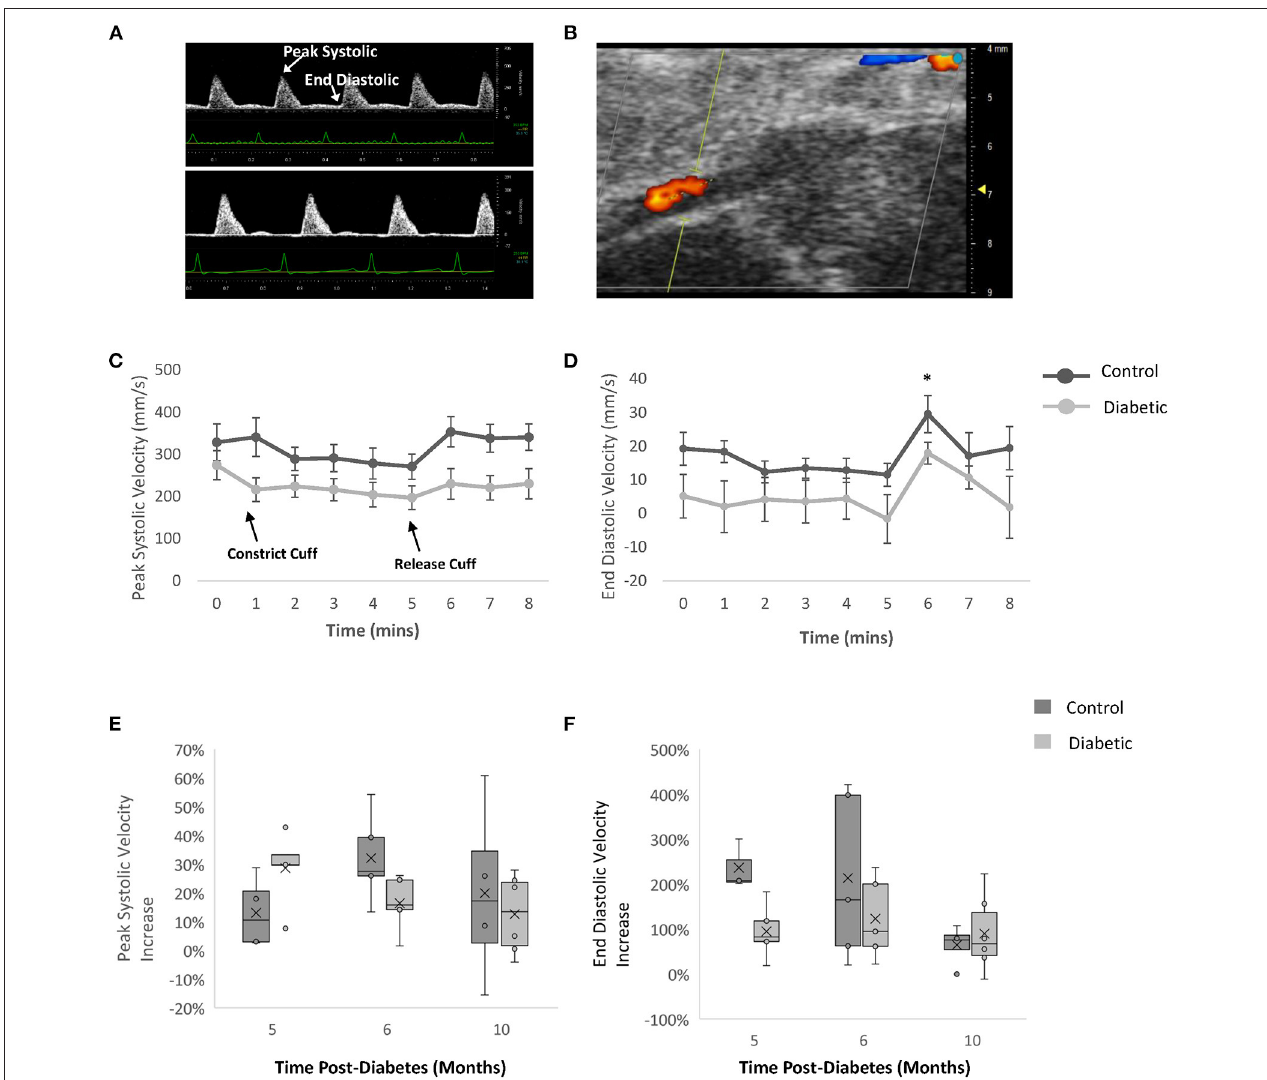
FIGURE 7 | Flow-mediated dilation measurements of femoral artery by Doppler ultrasound. Blood velocity measured via color Doppler with a cuff on the ankle at Month 5, 6, and 10 post-diabetes. (A) Femoral artery Doppler ultrasound images at Month 6 - baseline for male control (top) and diabetic (bottom) rats. (B) Representative femoral artery color Doppler ultrasound image at Month 6 – baseline. (C) Peak systolic velocity and (D) end diastolic velocity at Month 6 post-diabetes measured in control ( n = 5) and diabetic ( n = 5) rats. Significance was evaluated between pre-cuffing (5min) and cuff release (6min), and difference was observed for both control and diabetic cohorts. Relative change in (E) peak systolic velocity and (F) end diastolic velocity post-cuff release, measured at Month 5 ( n = 5 control, n = 5 diabetic), Month 6 ( n = 5 control, n = 5 diabetic), and Month 10 ( n = 4 control, n = 6 diabetic) post-diabetes. Line graphs represented as mean ± SEM. Box plot mean value is represented with the symbol “X.” Significance at individual timepoints is indicated (* p <